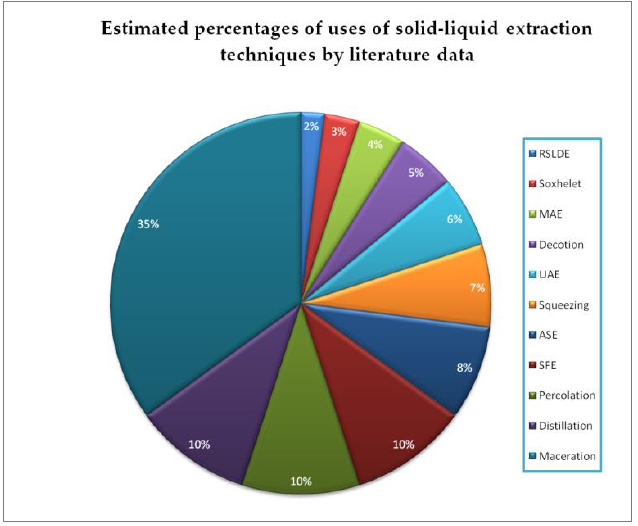
Figure 2. Pie chart showing the percentage of applications of each cited extraction technique.